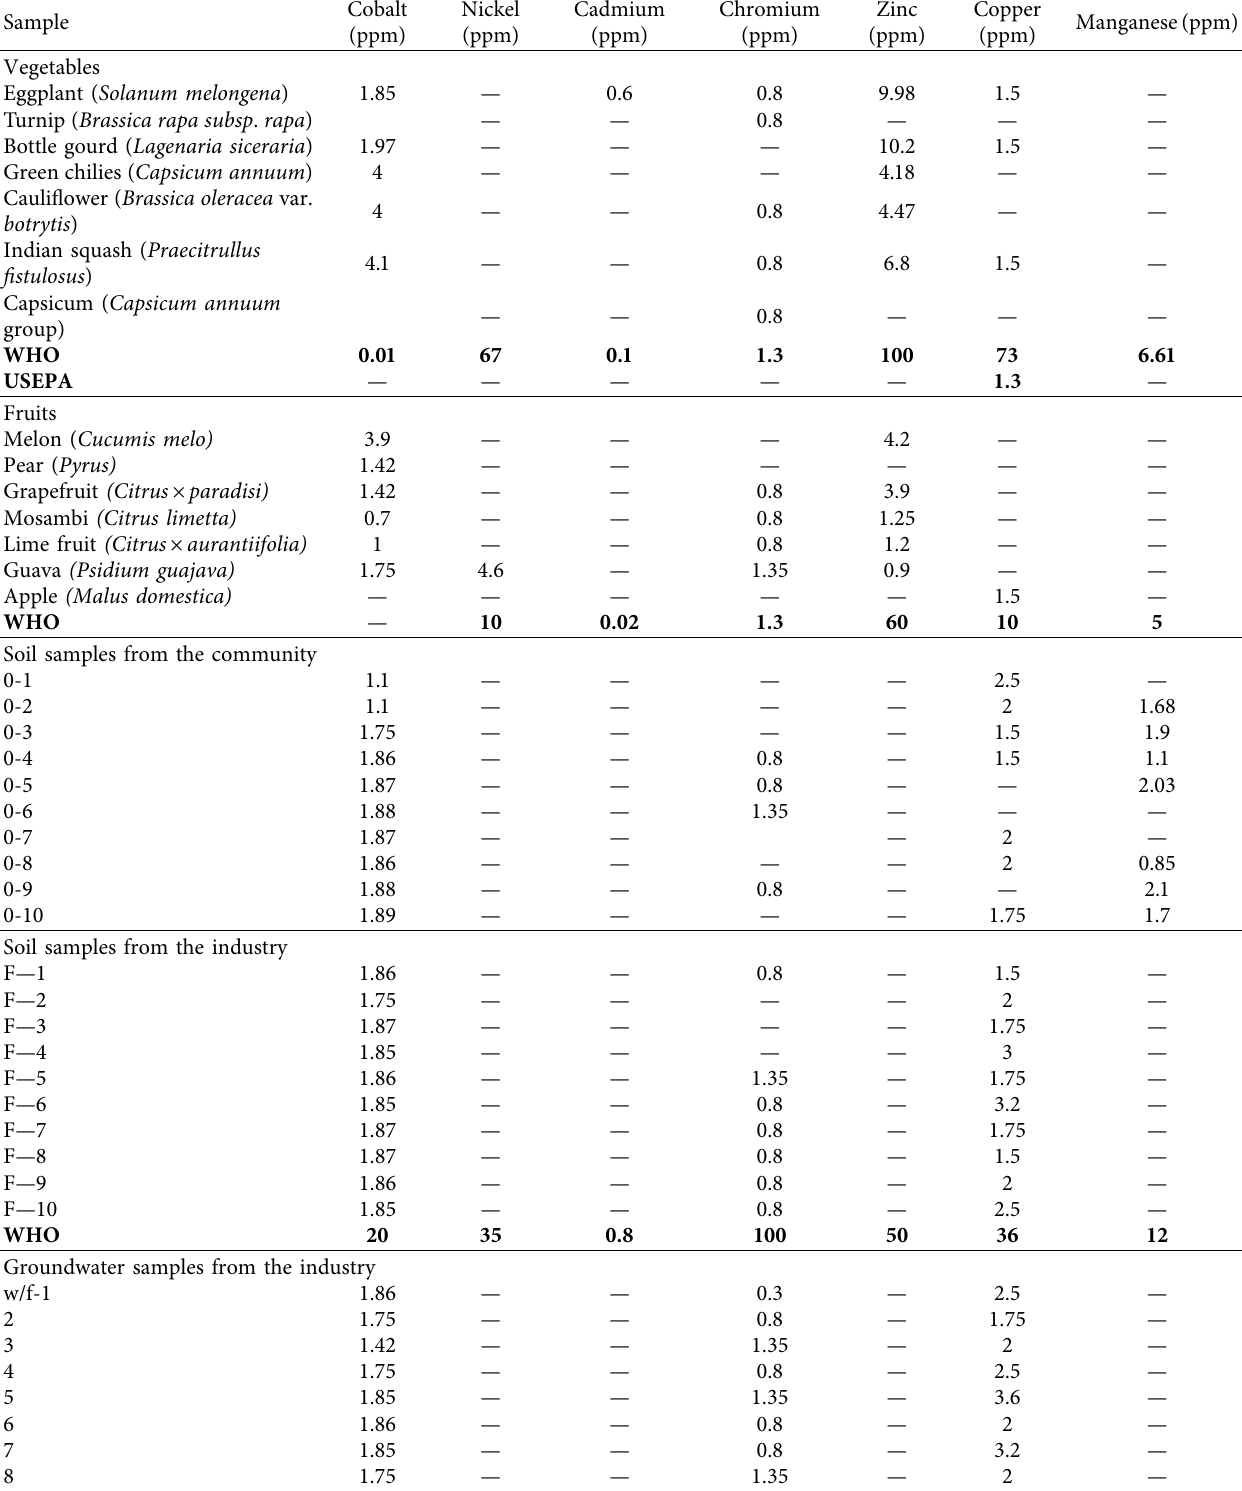
Table 1: Results of heavy metal concentration in